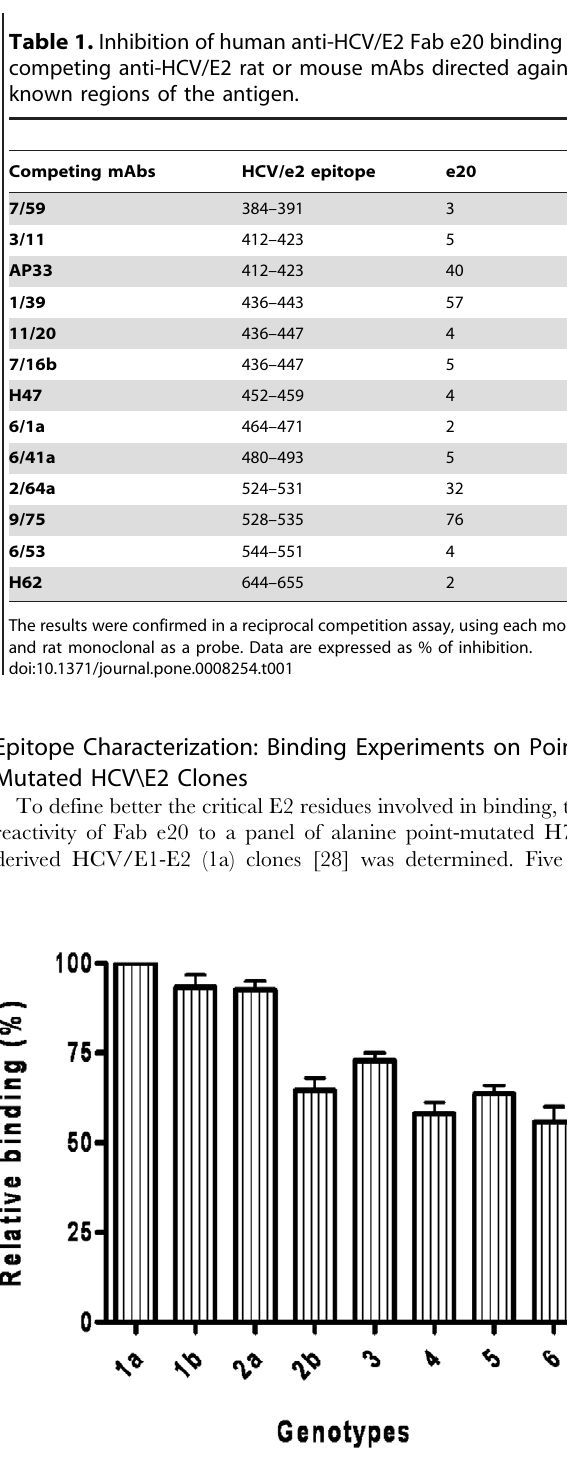
Figure 1. Binding activity of Fab e20 on E1E2 derived from different HCV genotypes. The following strains were used: genotype 1a (isolate H77.20); 1b (UKN1B12.16); 2a (UKN2A.2.4); 2b (UKN2B2.8); 3 (UKN3A1.28c); 4 (UKN4.21.16); 5 (UKN5.15.11) and 6 (UKN6.5.8). The broadly cross-reactive monoclonal AP33 was used to assess that the efficiency of transfection was comparable for all different genotypes. Binding activity for each genotype is expressed as percentage of the reactivity observed on E1E2 of genotype 1a (H77 strain). The means and standard errors of two replicate assays are reported.